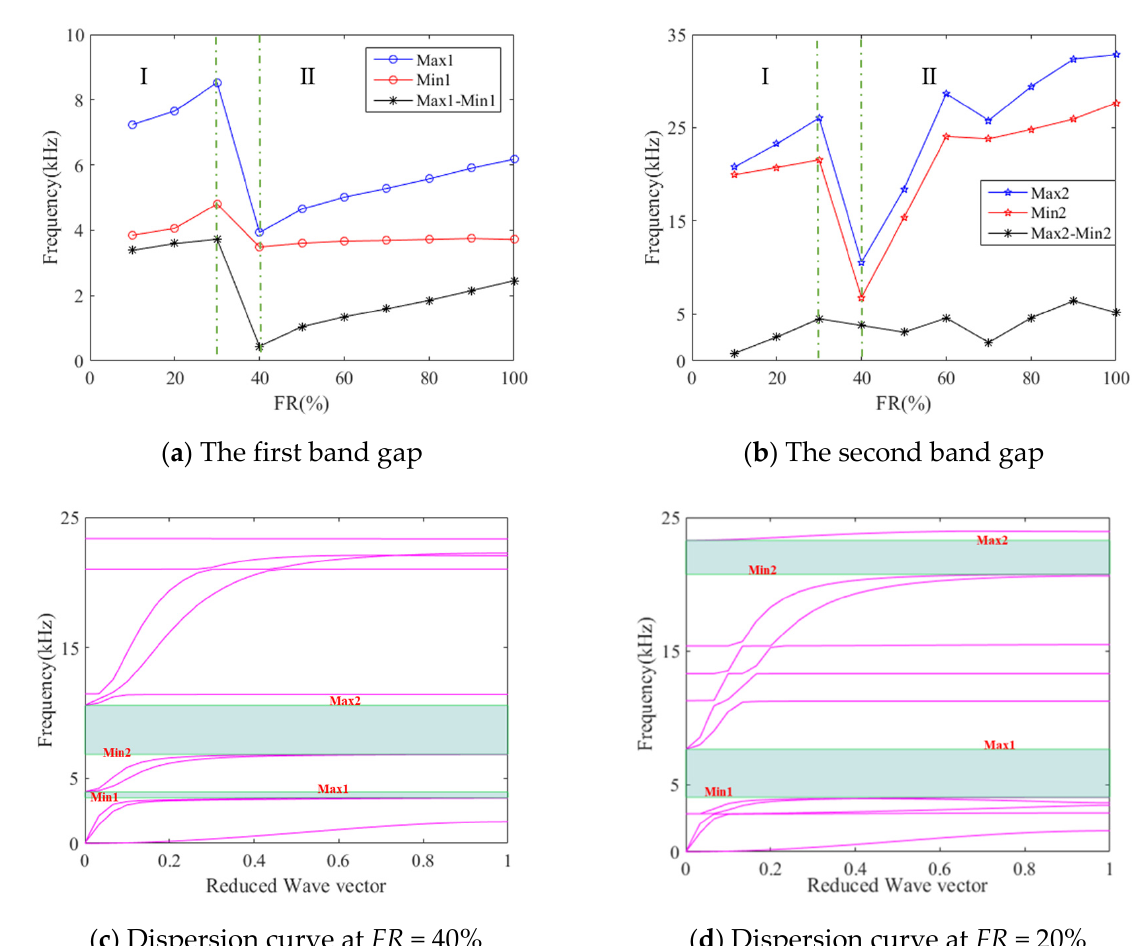
Figure 9. Dispersion curve and the value of band gap with different FR values. ( a ) The upper and lower boundary differences of the first band gap. ( b ) The upper and lower boundary differences of the second band gap. ( c ) Band gap selection for the filling ratio above 40%. ( d ) Band gap selection for the filling ratio below 40.